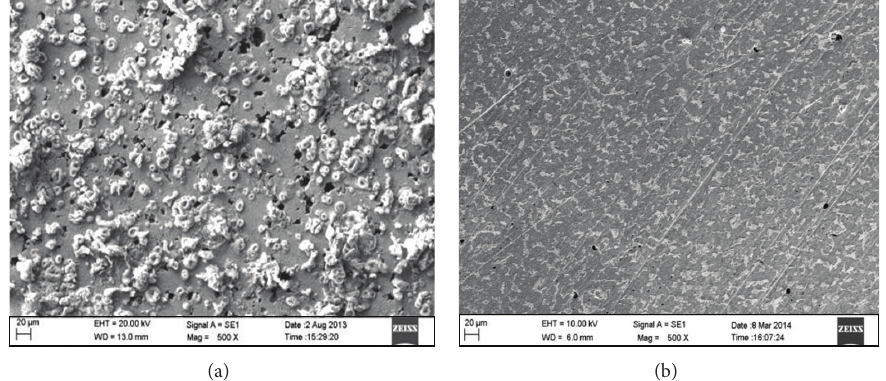
Figure 10: SEM images of the mild steel specimen after immersion in 1.0 M HCl (a) in the absence and (b) in the presence of